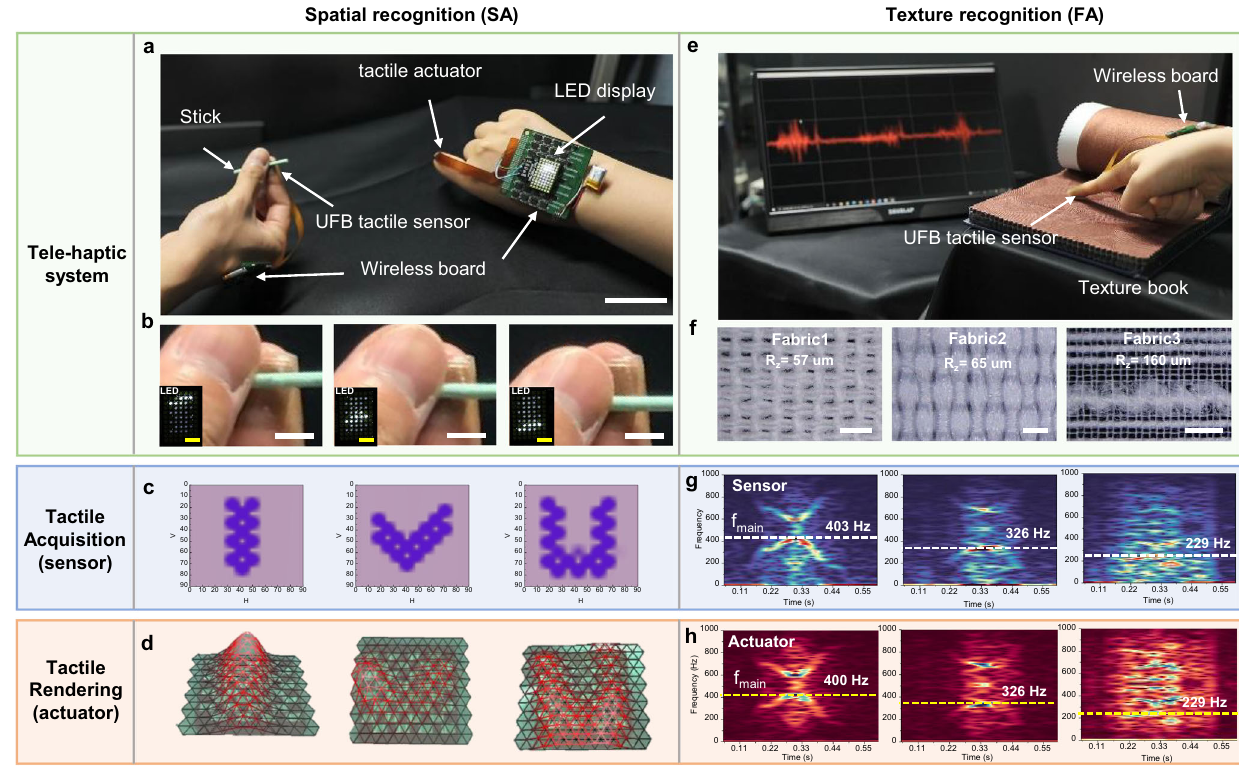
Fig. 5 Demonstration of a wireless telehaptic system. a Spatial distribution of tactile stimuli (static pressure) was acquired by UFB tactile sensor array and the signals were wirelessly transmitted to the actuator by the telehaptic system. Pressed position and pressure scale were visualized by the LED display pixels and their brightness, scale bar is 5 cm. b Magni fi ed image of pressed positions (top, center, bottom) on the UFB tactile sensor by a stick, scale bar is 1 cm. Insets are illuminated LED pixels indicating sensor signal for each position, scale bar is 3 mm. c Pressure in the form of letter shapes (I, V, U) was applied to the UFB tactile sensor and displayed by the graphical use interface (GUI). d 3D scan image of vibrational displacement while acquiring sensor signals rendered by the actuator array. e Texture information (dynamic pressure) was acquired by UFB sensor while rubbing the different fabrics. f 3 different types of fabric with various roughness. Fabric 1 is rough, fabric 2 is smooth, and fabric 3 is bumpy because of the height differences in the fi ber bundles, scale bar is 1 mm. g STFT spectrogram of sensor signal corresponding to fabric 1 (left), fabric 2 (center), and fabric 3 (right). h STFT spectrogram of the measured vibration velocity of the actuator for each